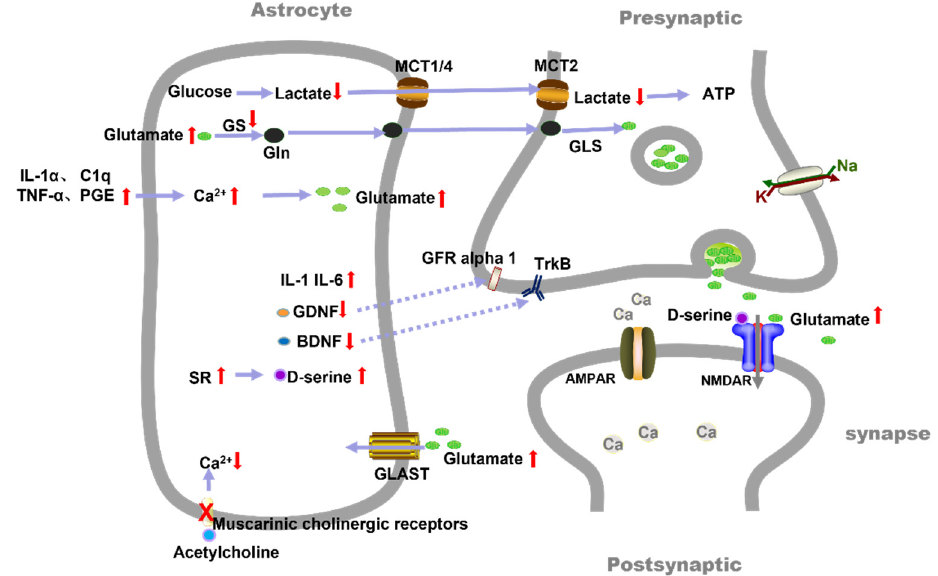
Figure 2. The role of astrocytes in synapse and trophic metabolism. GLUT1/3: glucose transporter 1/3. GLU: Glutamate. GS: Glutamine synthetase. Gln: glutamine. GLS: Glutaminases. GDNF: glial cell line-derived neurotrophic factor. GLT-1/GLAST: glutamate transporters. MCT1/2/4: monocarboxylate transporters 1/2/4. SR: serine racemase. TNF- α : Tumor necrosis factor- α . PGE: prostaglandin E. BDNF: Brain-derived neurotrophic factor. TrkB: BDNF receptors. GFR a lph a 1 : GDNF receptors. GDNF